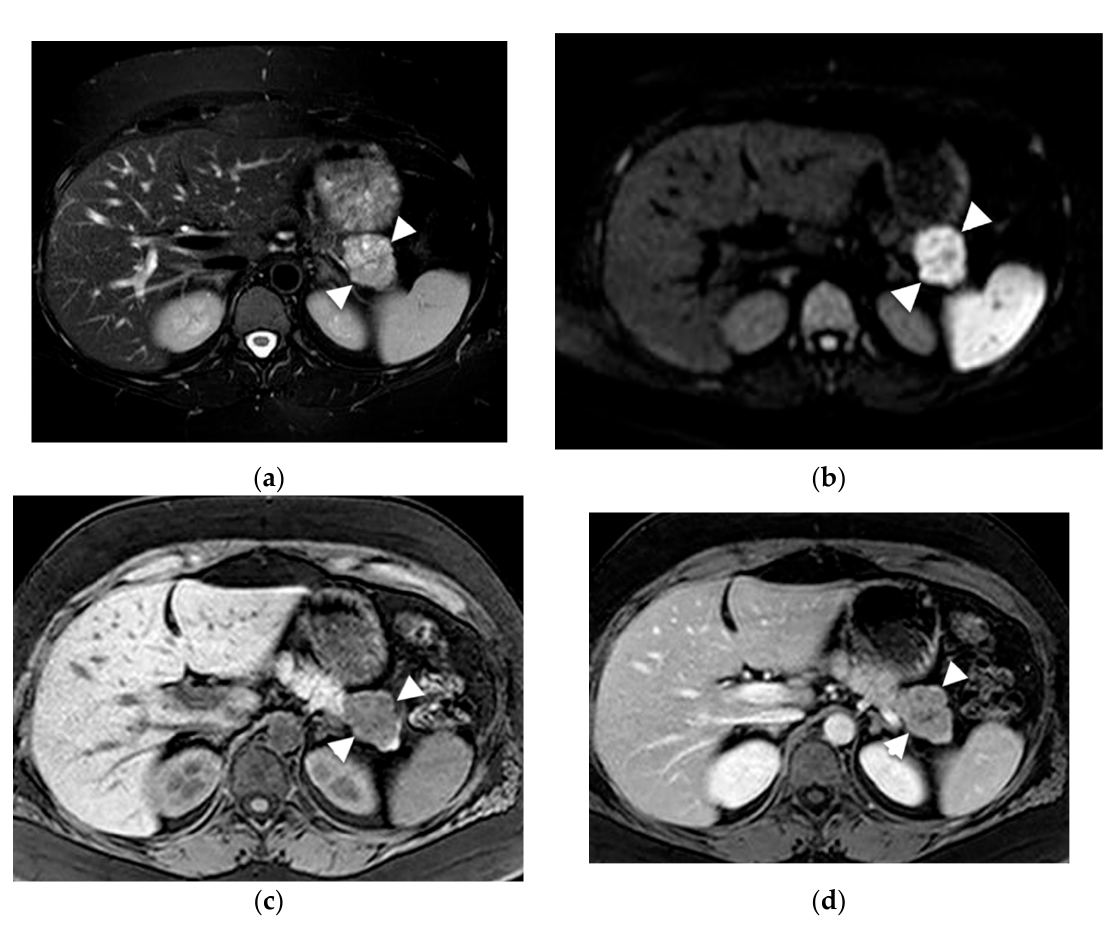
Figure 8. SPN. Young female with incidental pancreatic lesion. ( a ) Axial T2-weighted image demon- strates a heterogenous T2 hyperintense lesion in the tail (arrowheads). ( b ) Axial DWI image demon- strates increased signal indicating a cellular lesion. ( c ) Axial T1-weighted pre and ( d ) T1-weighted post IV contrast indicating central enhancement in the lesion.